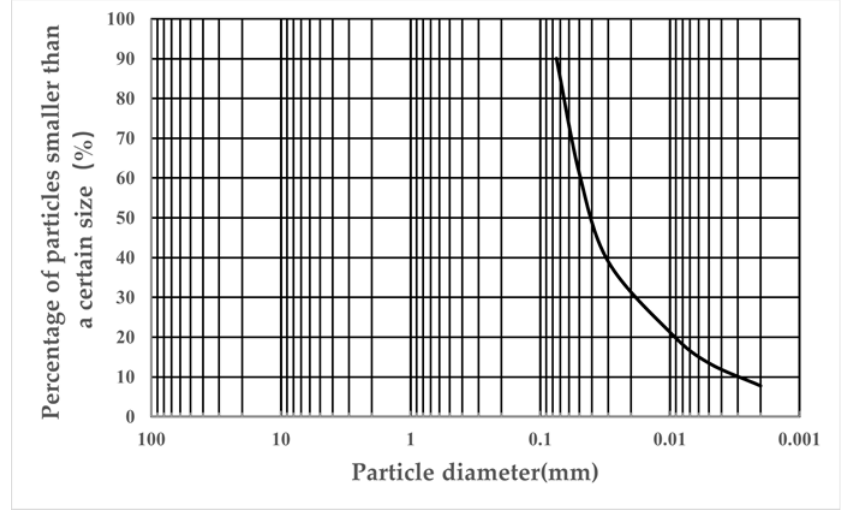
Figure 3. Particle distribution curve.